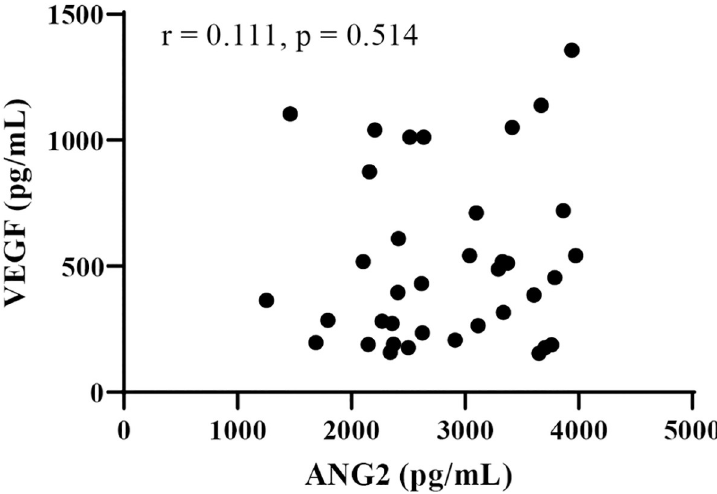
Fig 2. Correlation between baseline serum VEGF and ANG2 levels. ANG2: angiopoietin 2, VEGF: vascular endothelial growth factor.